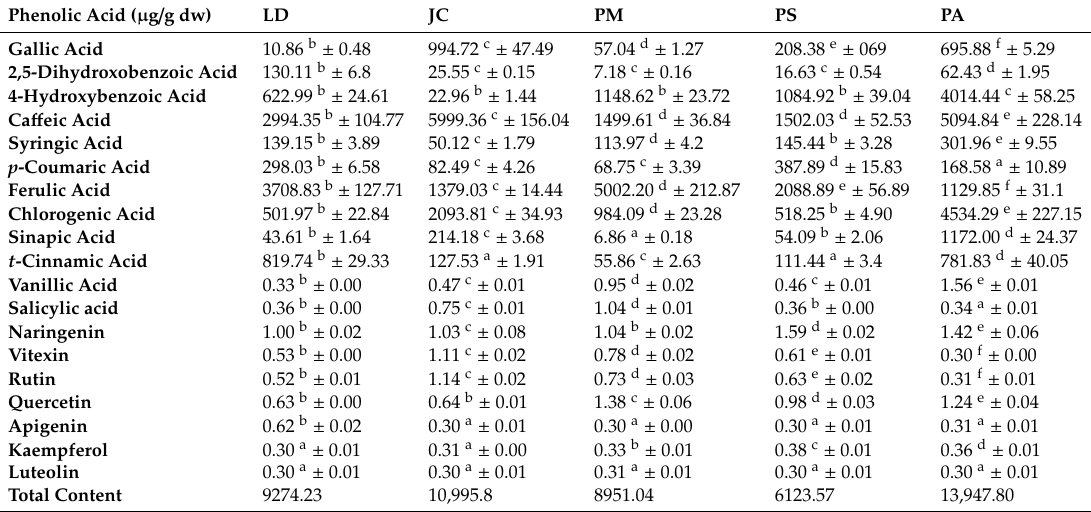
Table 2. HPLC analysis of phenolic compounds in tested conifer shoot